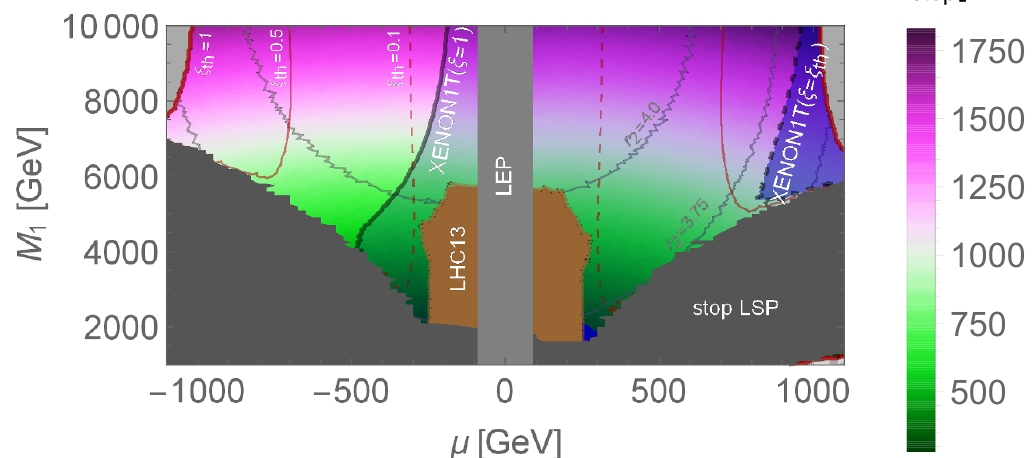
Figure 3 . Values of the dark matter observables with M 3 = 1 : 0 TeV. Meanings of the lines and regions are same as in (cid:12)gure 2. In addition, the brown region is excluded by the top squark search at the LHC and the top squark becomes LSP in the dark gray region.